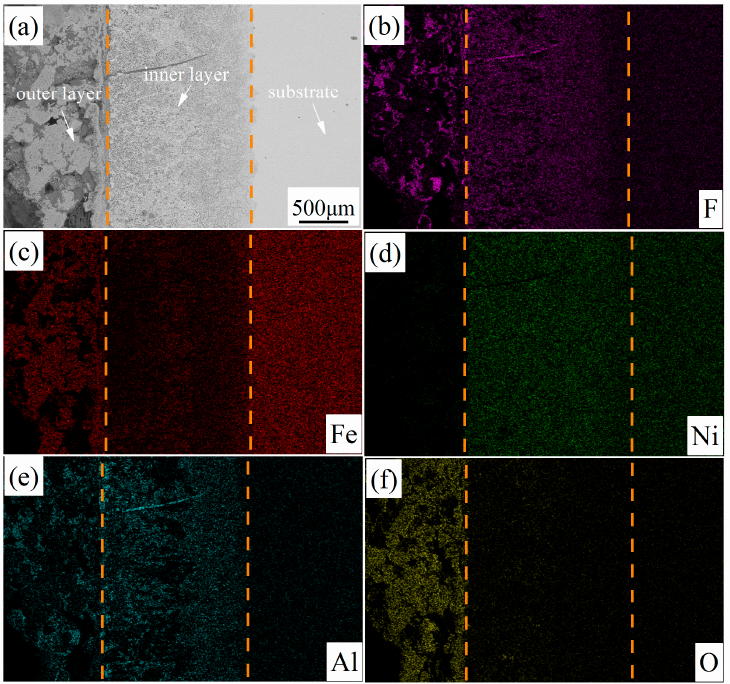
Figure 4. The SEM cross-section micrograph ( a ) and EDS mapping with respect to F ( b ), Fe ( c ), Ni ( d ),